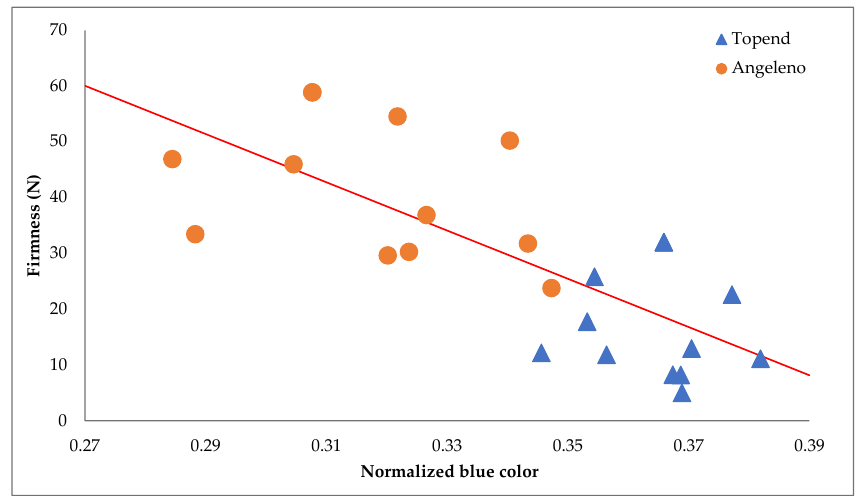
Figure 8. Relationship of normalized blue value and firmness for ‘Angeleno’ and ‘Topend’ cultivars.